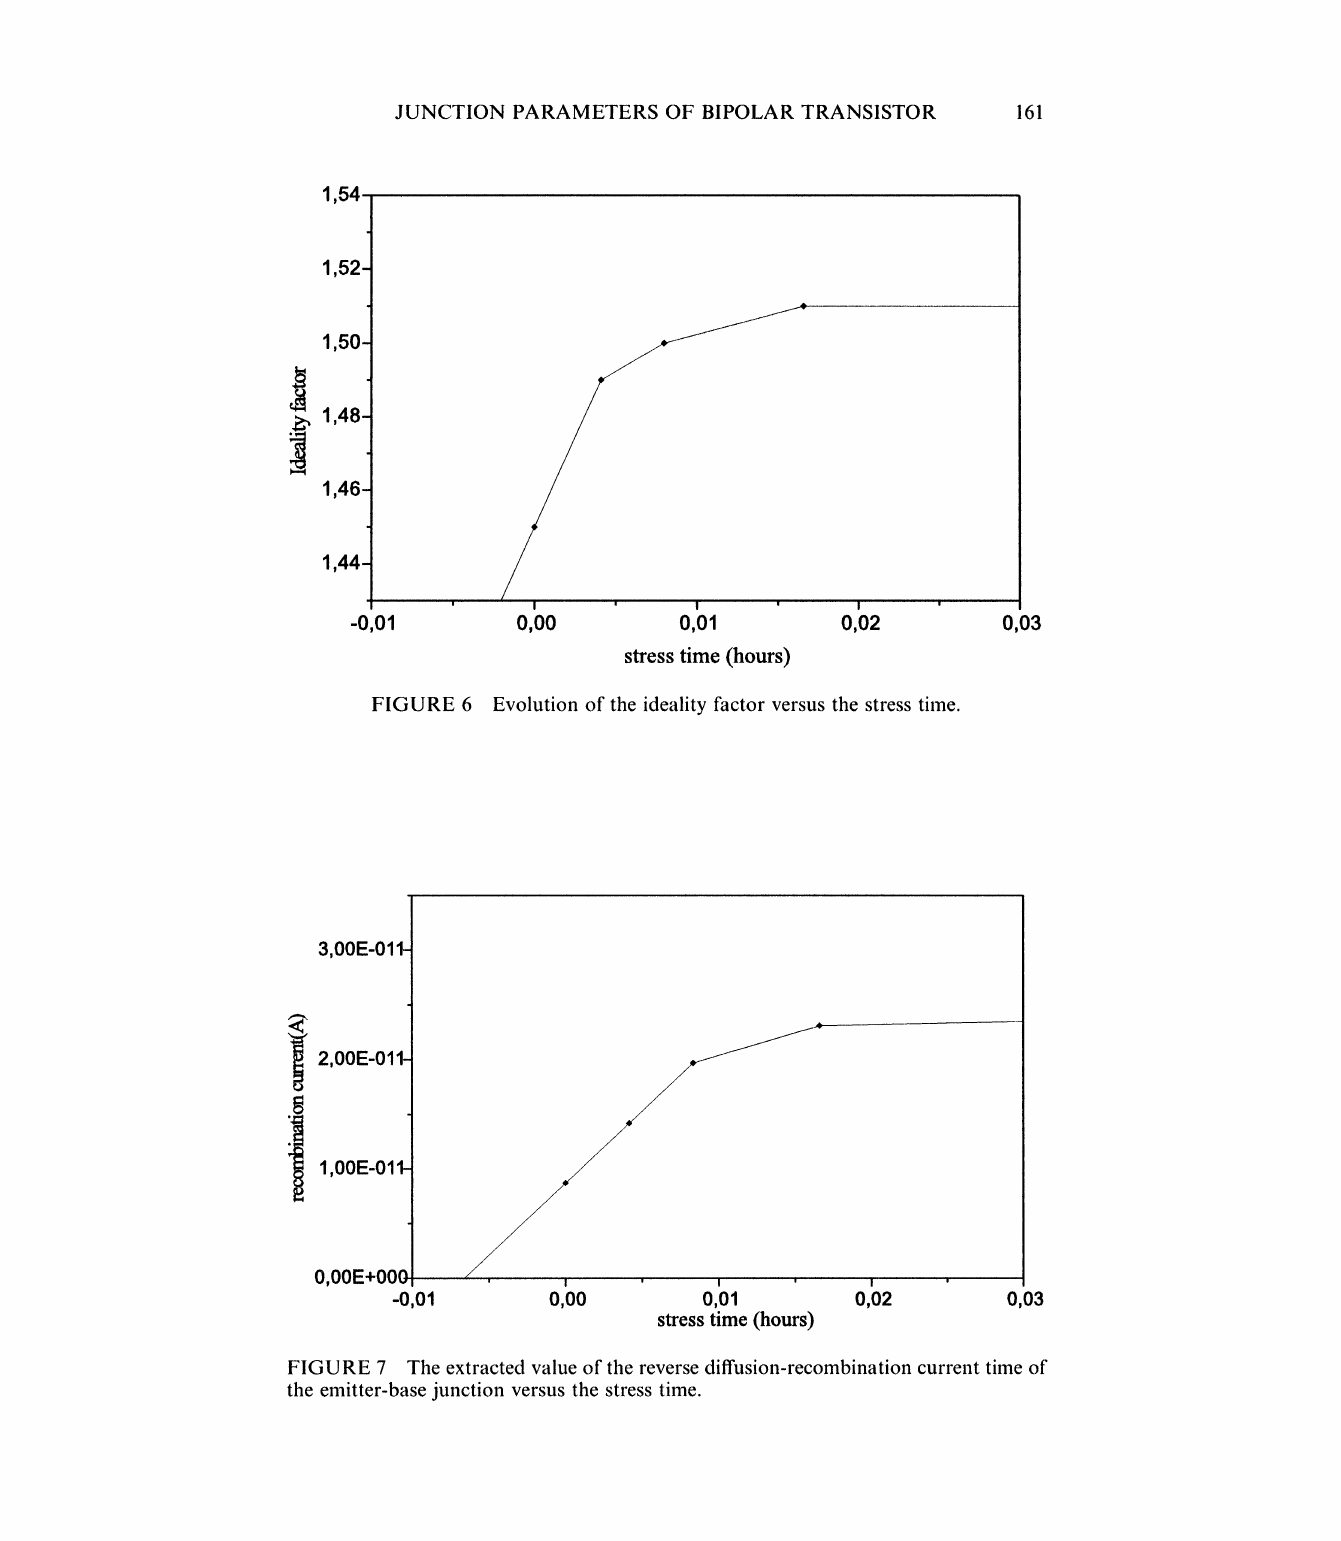
FIGURE 7 The extracted value of the reverse diffusion-recombination current time of the emitter-base junction versus the stress